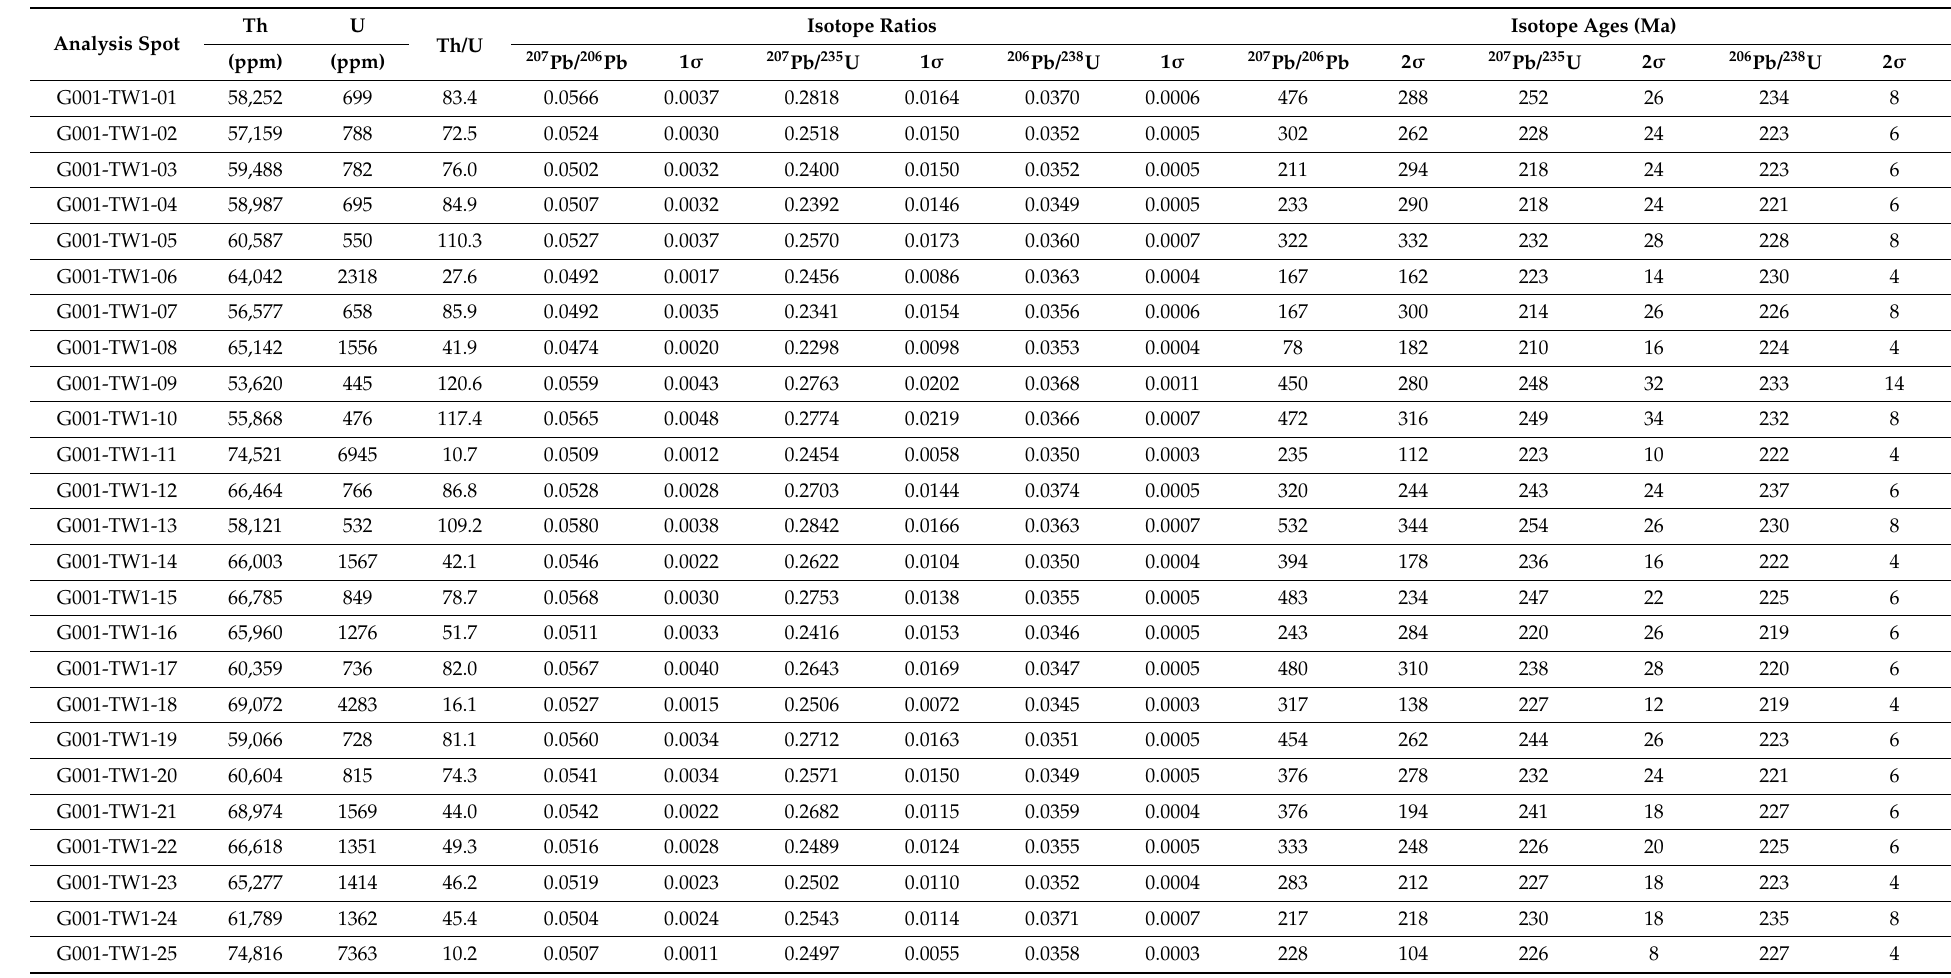
Table 2. LA-ICP-MS monazite U-Pb dating data of Baishi